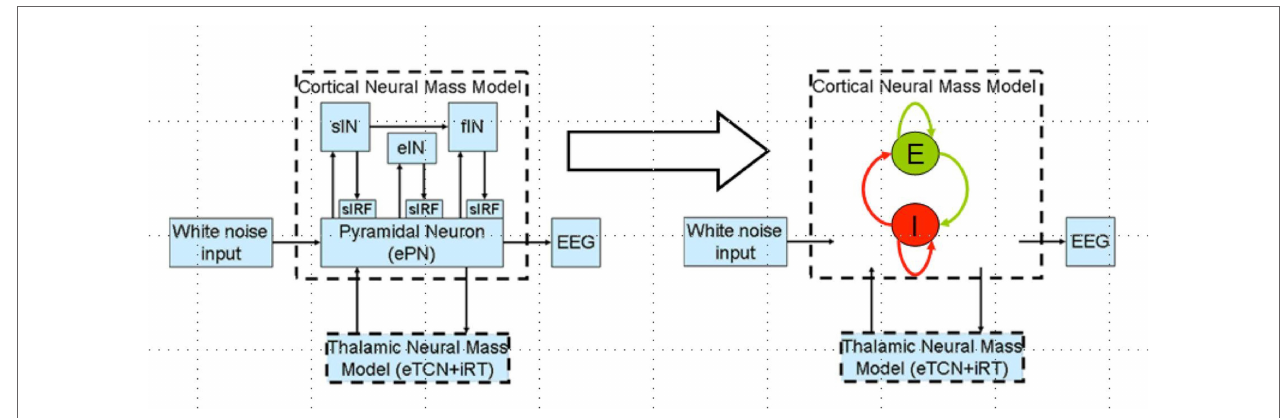
FiGUre 3 | thalamocortical neural mass model (left panel) and a reduced network model of the cortical neural mass containing two populations (excitatory, e and inhibitory, i) of adaptive neural masses receiving recurrent external inputs from thalamic neural mass (right panel)